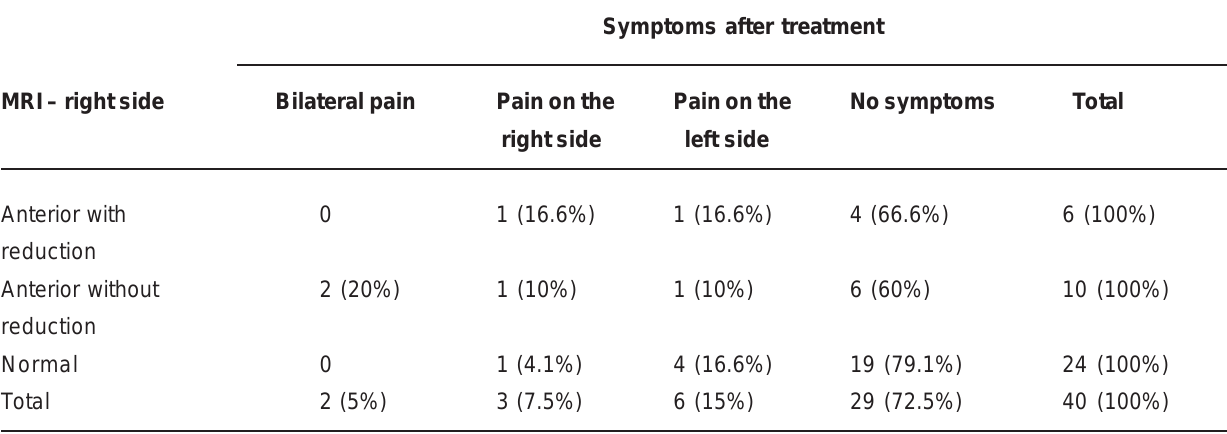
TABLE 2 - Distribution of the patients according to the MRI results for the right side and symptoms after treatment